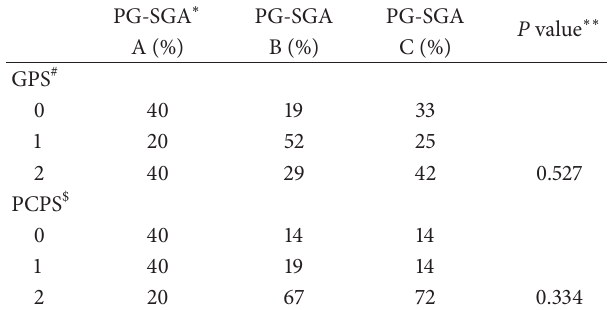
Table 6: The differences between metastatic and nonmetastatic patients with inoperable gastric adenocarcinoma in terms of PG- SGA, GPS, and